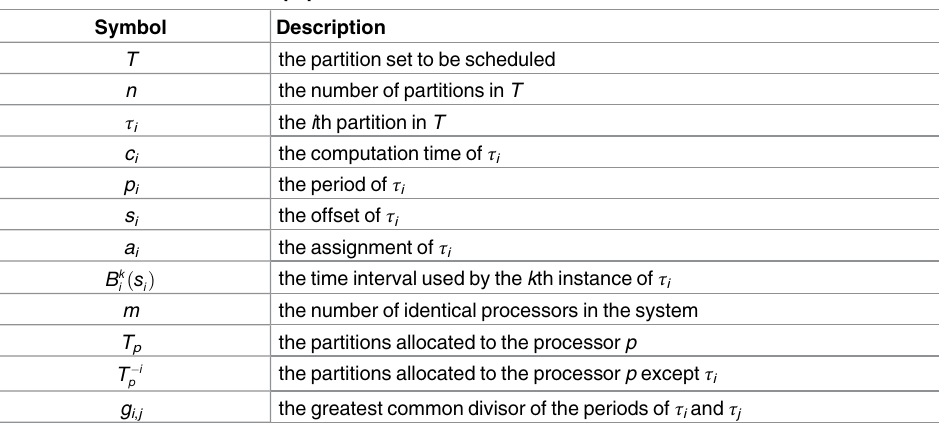
Table 1. Notations used in this